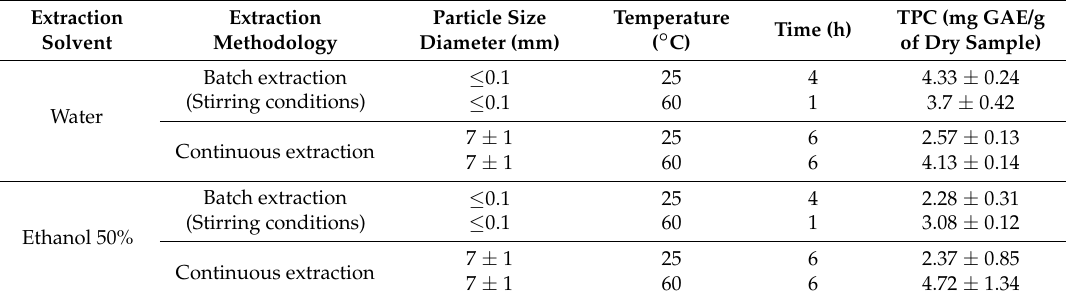
Table 3. Comparison between the use of batch or continuous solid-liquid extraction in TPC obtainment form Sterculia apetala seeds samples varying in particle size and extraction